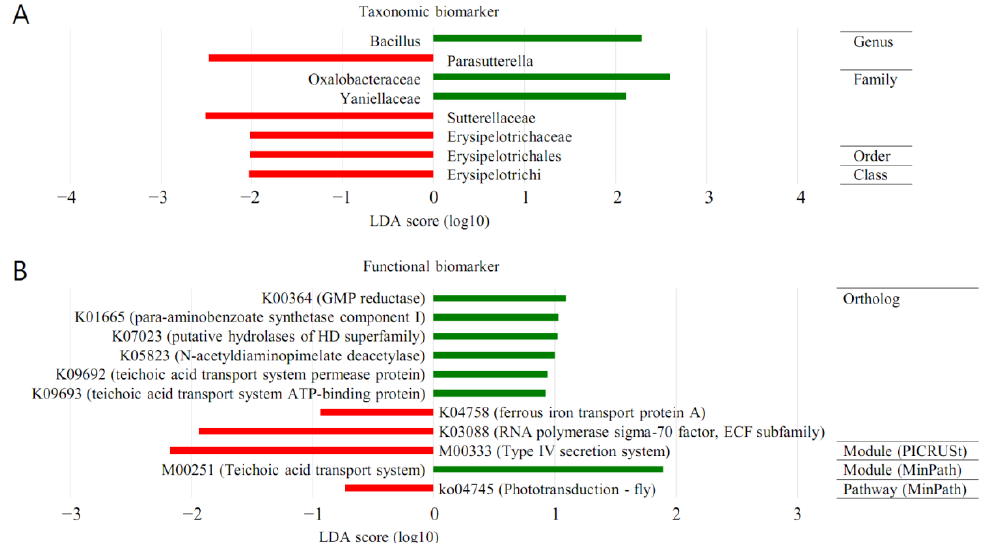
Figure 5. Discovery of taxonomic biomarkers and functional biomarkers in malignant prostate cancer tissues (MT) and peri-malignant prostate cancer benign prostatic tissues (BT) using LEfSe (linear discriminant analysis effect size) analysis. ( A ) In addition to taxonomic biomarkers, ( B ) functional biomarkers were analysed in ortholog, module, and pathway. For module and pathway, PICRUSt (phylogenetic investigation of communities by reconstruction of unobserved states) and MinPath (minimal set of pathways) methods were applied, but there was no significant finding when PICRUSt was applied to pathway. The KEGG (Kyoto Encyclopedia of Genes and Genomes) Database was used for functional biomarker analysis. The red area indicates more abundance in the MT group, and the green area represents vice versa.